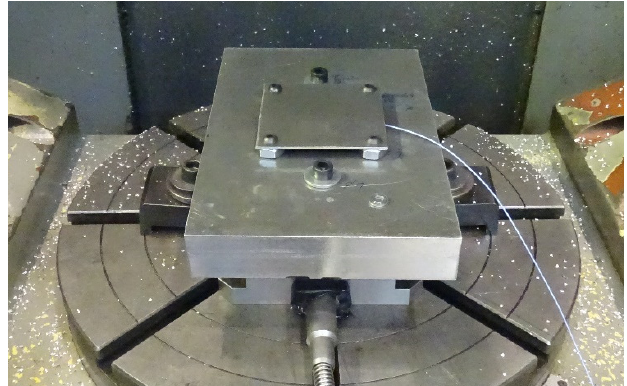
Figure 1. General setup of a sample to be machined, with the accelerometer below.